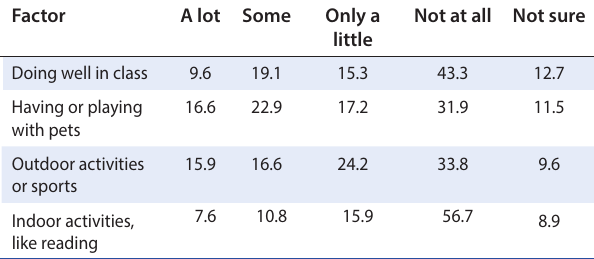
Table 5: Extent to which the symptoms of rhinitis limit the activities of the participants ( n = 157) (%)